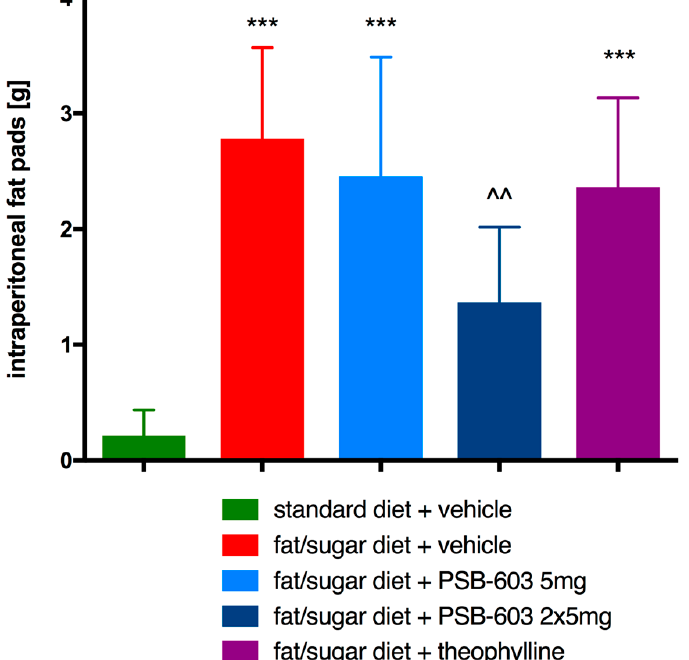
Figure 3. Effect of PSB-603 administration on the mass of adipose pads. Results are expressed as means ± SD, n = 7–8. Multiple comparisons were made using Tukey post hoc one-way ANOVA. * Significant against control mice fed standard diet; ^ significant against control mice fed a fat/sugar diet; ^^ p < 0.01, *** p < 0.001. Locomotor activity was determined in mice after a single intraperitoneal administra- tion of PSB-603 at doses of 10, 5, and 1 mg/kg b.w. Only at a dose of 10 mg/kg b.w. did the antagonist significantly decrease locomotor activity (F(3,30) = 9.743, p = 0.0001). The results are shown in Figure 4.